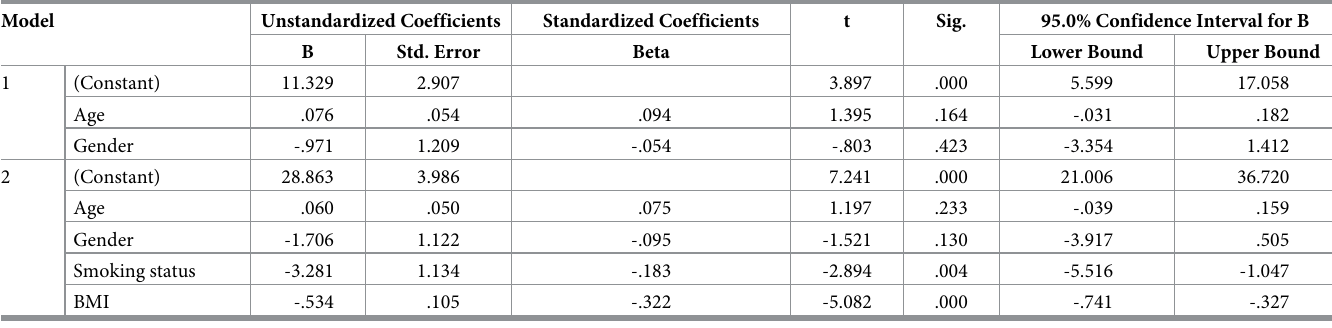
Table 2. Linear regression analysis showing effects of high BMI, and smoking on vitamin D level.